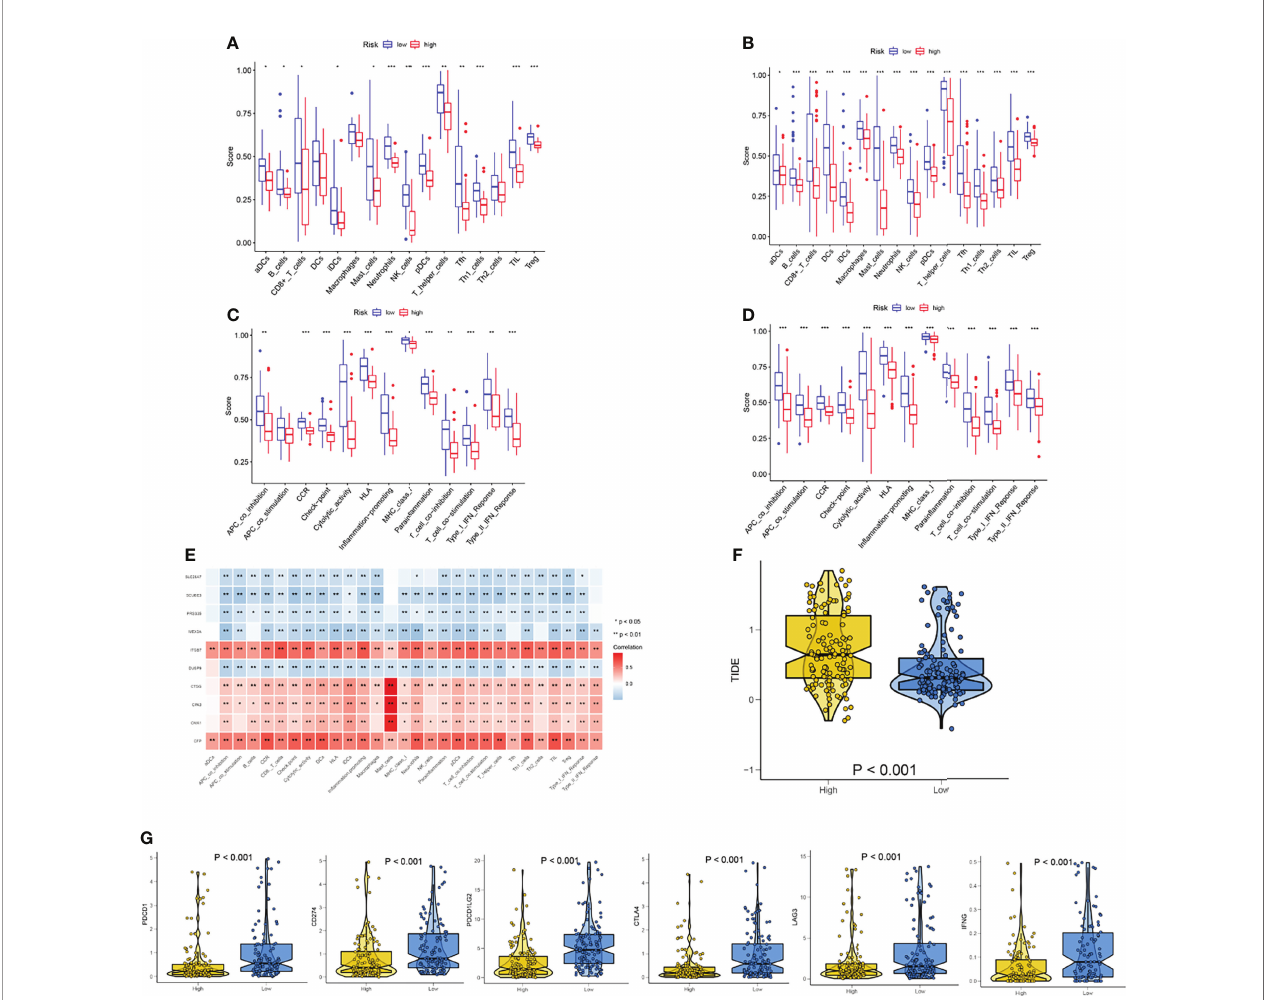
FIGURE 8 | Analysis of immune status based on necroptosis-related risk score. (A, C) Comparisons of immune cells and immune functions between different risk groups in TCGA-SARC cohort. (B, D) Comparisons of immune cells and immune functions between different risk groups in GSE17118 cohort. (E) The correlation of the expression level of signature genes and immune cells. (F) The differences in the TIDE score between two risk groups. (G) The differences in the expression of checkpoint and related immune genes between two risk groups. ns, p ≥ 0.05; *, 0.01 ≤ p < 0.05; **, 0.001 ≤ p < 0.01; ***, 0.0001 ≤ p < 0.001; ****p <